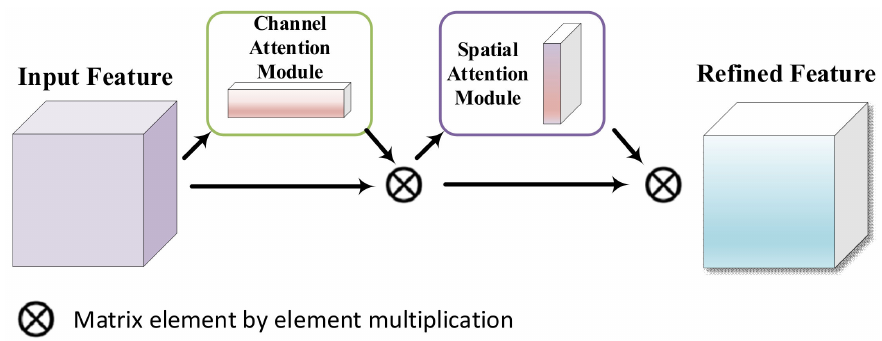
Figure 4. The framework of our